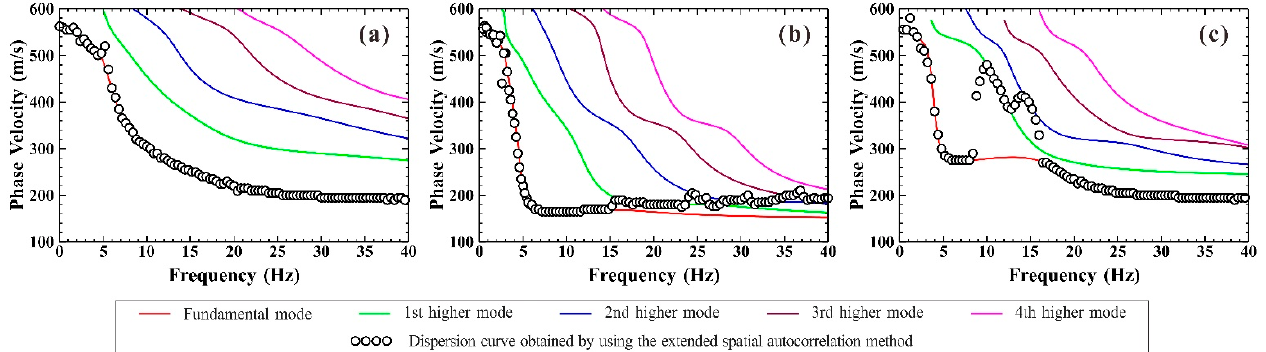
Figure 4. The Rayleigh wave dispersion curves obtained based on the extended spatial autocorrelation method and the theoretical calculation of the fundamental and first three high-order Rayleigh waves corresponding to the three geological models. ( a ) Model 1; ( b ) Model 2; ( c ) Model 3.